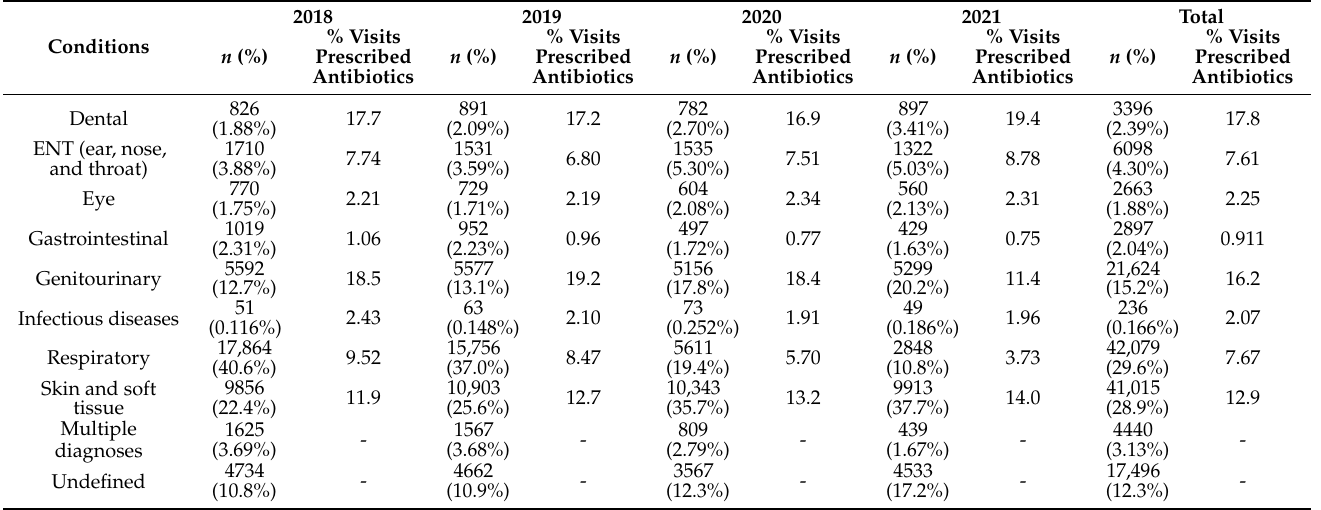
Table 2. Oral antibiotic prescriptions group by visit diagnoses, 2018–2021.